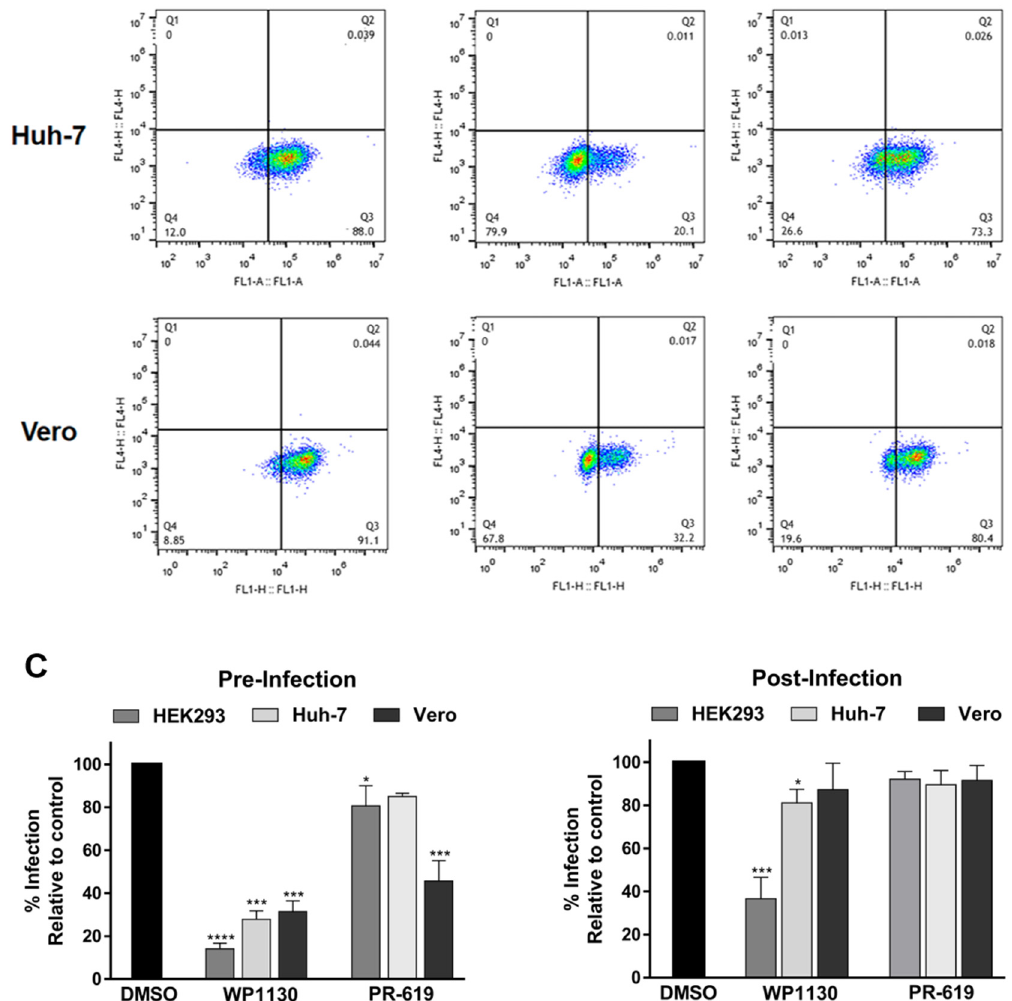
Figure 3. Deubiquitinating activity is required at an early stage of infection. ( A ) Schematic repre- sentation of the experiment. ( B ) Cells were treated with WP1130 at the indicated concentrations 1 h before infection or 4 h post-infection. Cells were collected 24 h later and analyzed using flow cytometry. ( C ) Infection rates normalized to control (DMSO). Data are represented as the mean + SD, and statistically significant differences are indicated as * p < 0.05, *** p < 0.001, **** p <